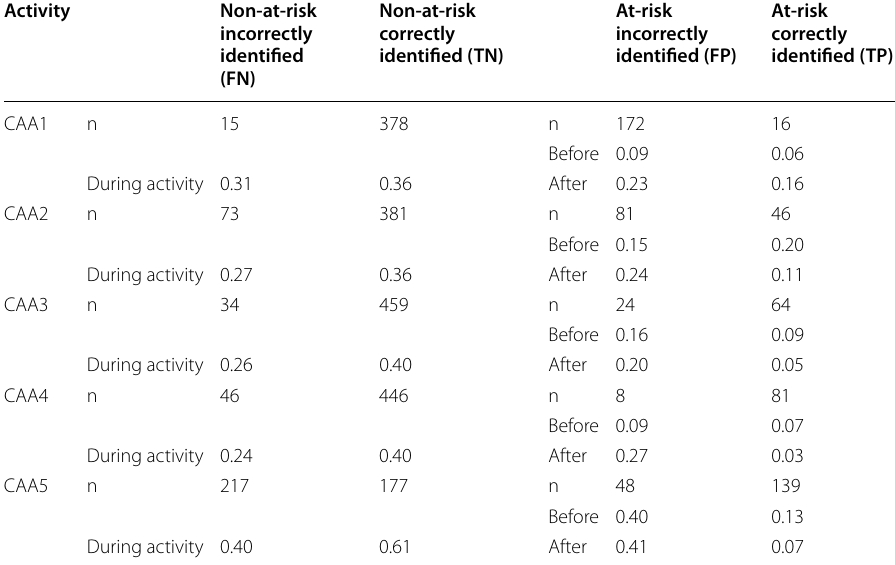
Number of learners who consented (n Table 3 Average access to the online classroom during activity duration by type of identified learner